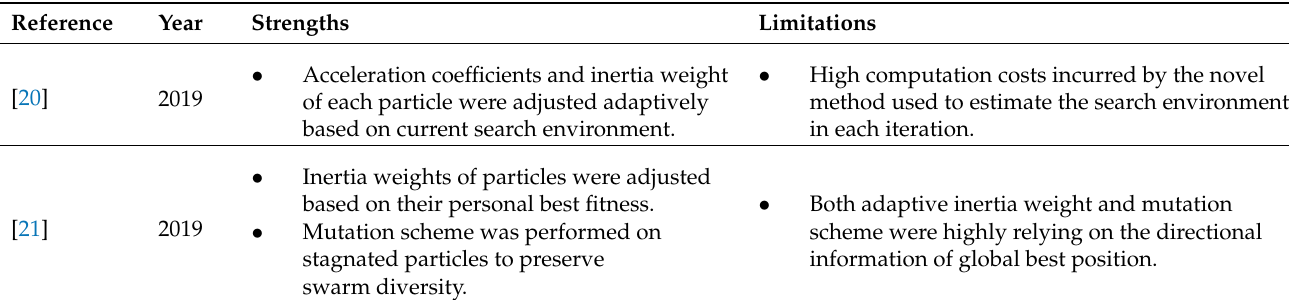
Table 1. Strengths and limitations of selected PSO